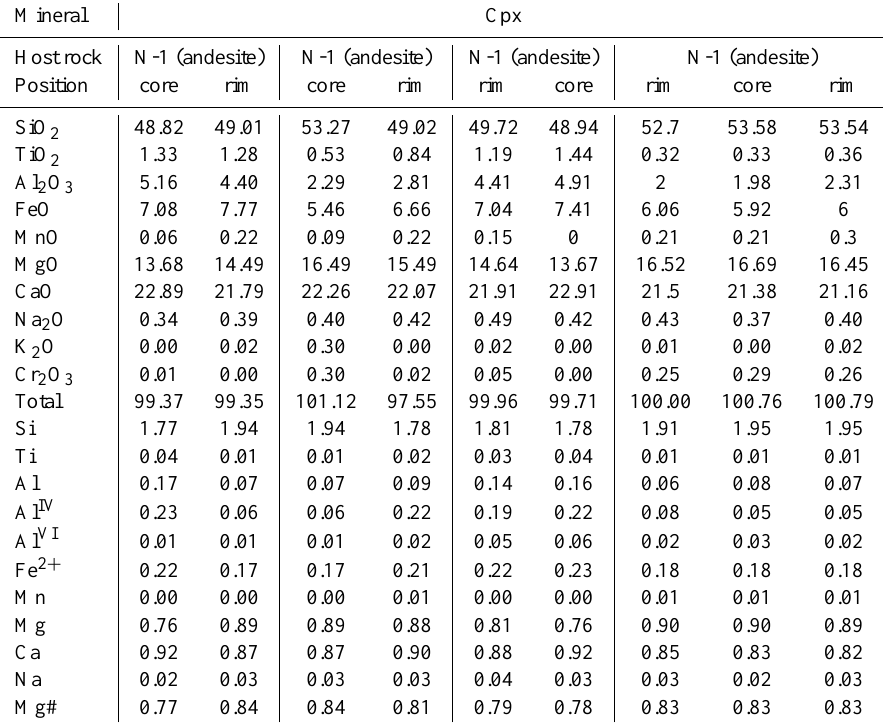
Table 4. Representative compositions of clinopyroxenes from post-ophiolite rocks in Sabzevar zone. Mineral Cpx Host rock N-1 (andesite) N-1 (andesite) N-1 (andesite) N-1 (andesite) Position core